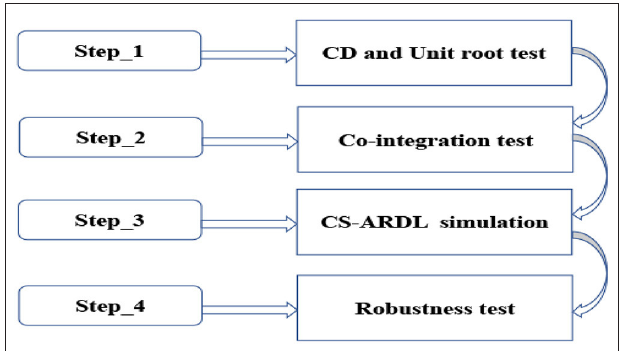
FIGURE 2 | Methodological frame work.